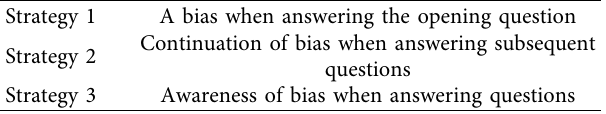
Table 4: Strategies used by participants in group 2 when answering questions. Strategy